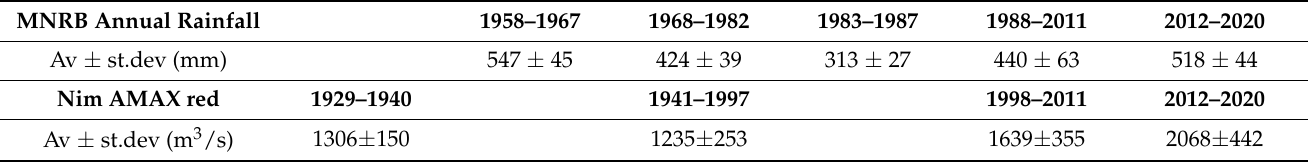
Table A3. Data series segmentation (Hubert with Scheff é test 0.01) of red AMAX at Niamey and annual precipitation over